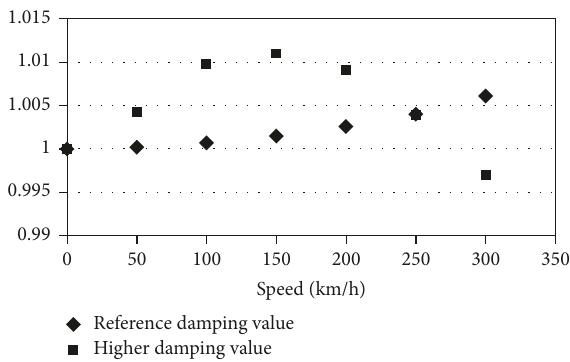
Figure 5: Dynamic factor due to damping in the case of the Timo- shenko beam for various properties of rail foundation